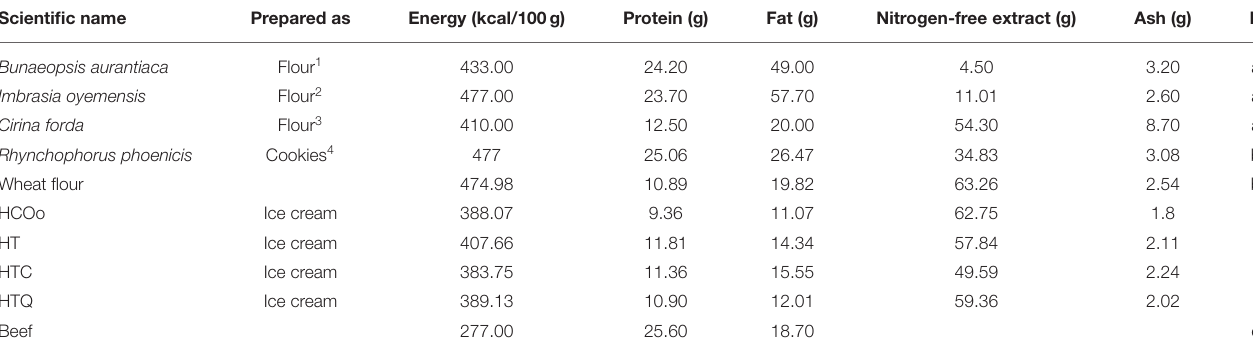
TABLE 3 | Comparative analysis of the nutritional value of ice cream with other foods made from insects and beef at a g/100g dry